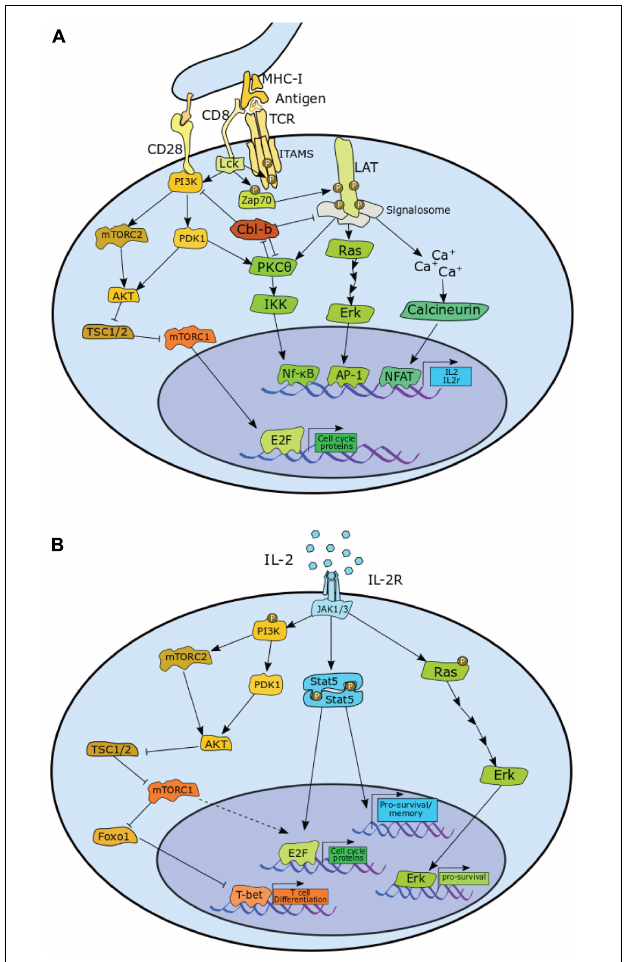
FIGURE 2 | Pathways in CD8 + T cells that contribute to the proliferation via upregulation of E2F and pro-survival signals, or contribute toward differentiation in both (A) antigen induced activation phase and (B) the IL-2 mediated expansion phase CD8 + T cells. P, phosphorylation. A detailed description is provided in the main